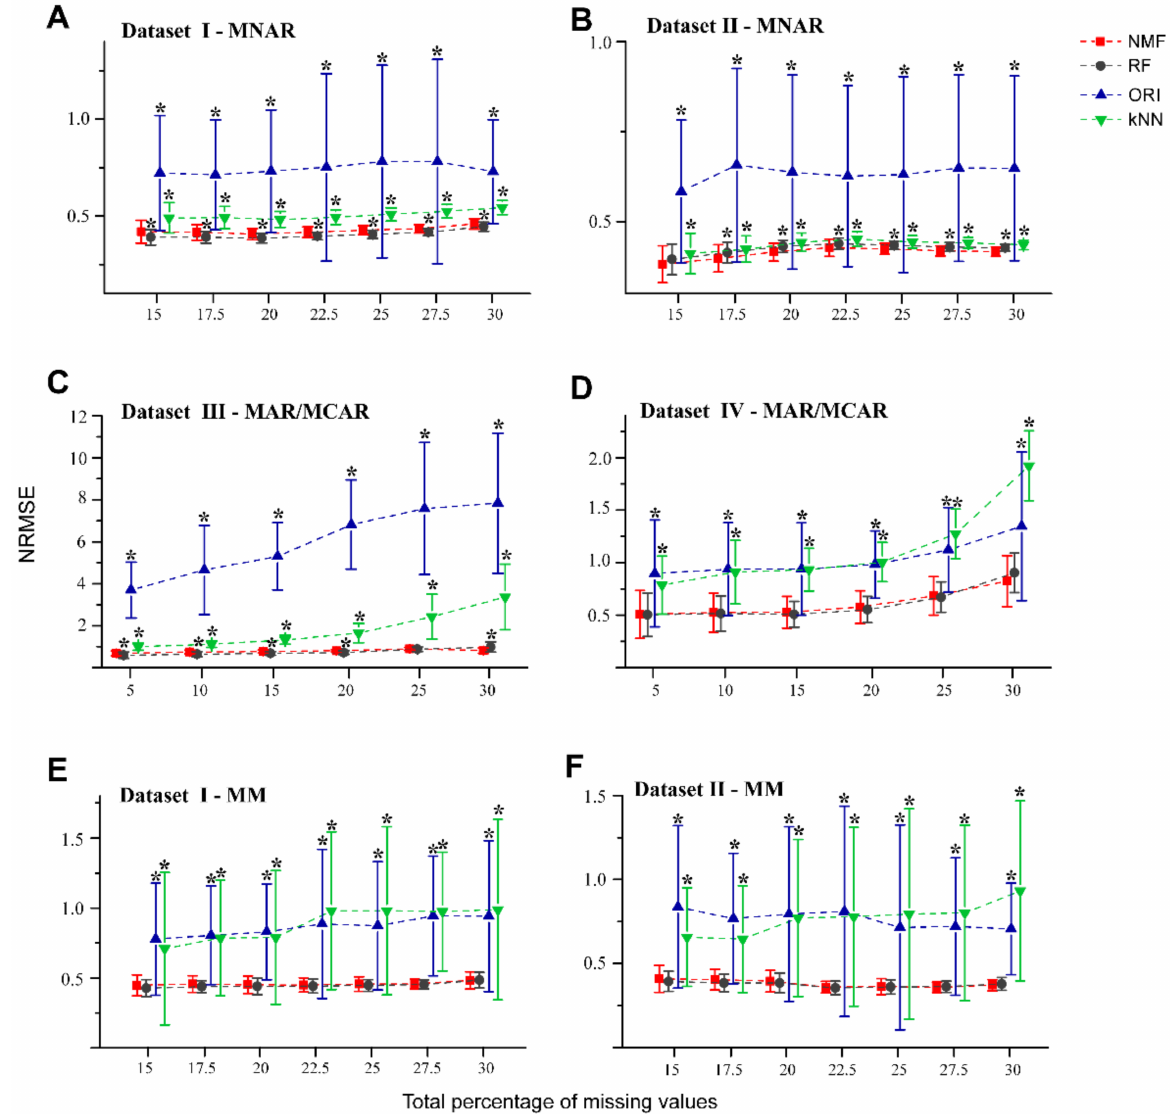
Figure 2. NRMSE curves obtained from the NMF, RF, ORI, and kNN methods applied on MNAR and MM patterns and MAR/MCAR patterns with different missing percentages. Fifty missingness datasets were generated randomly from Dataset I ( A , E ), Dataset II ( B , F ), Dataset III ( C ), and Dataset IV ( D ). Error bars represent the standard deviation with * denoting p < 0.05 ( t -test with BH adjusted) relative to the NMF-based